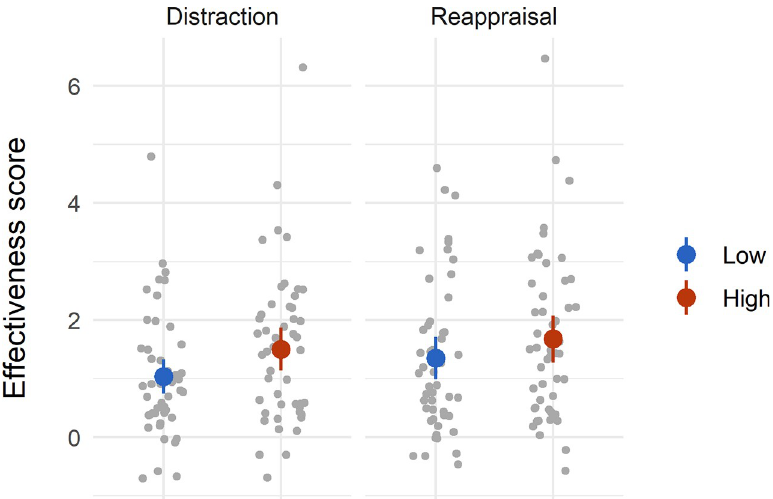
Fig 1. Effectiveness of regulatory strategies compared to intensity levels (Experiment 1B, N = 50). Error bars represent 95% confidence intervals (CI). Mean effectiveness scores can range between 0 to 8.